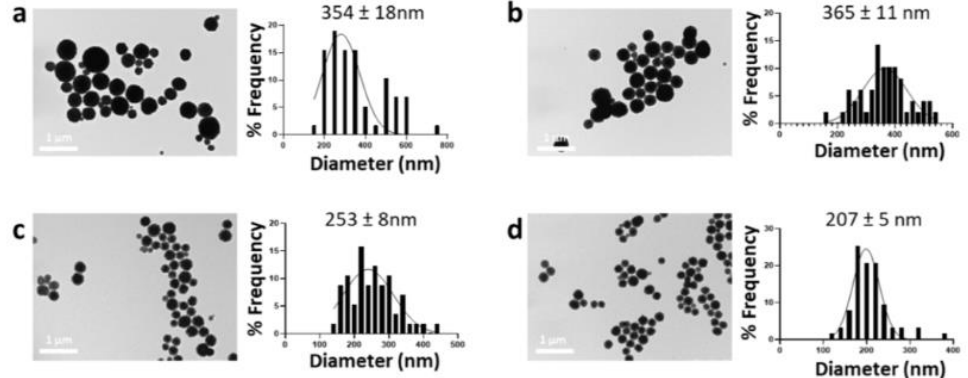
Figure 6. TEM images and size distribution of CaCO 3 NPs prepared with varying salt concentrations to 0.1 ( a ), 0.05 ( b ), 0.025 ( c ), and 0.01 M ( d ).